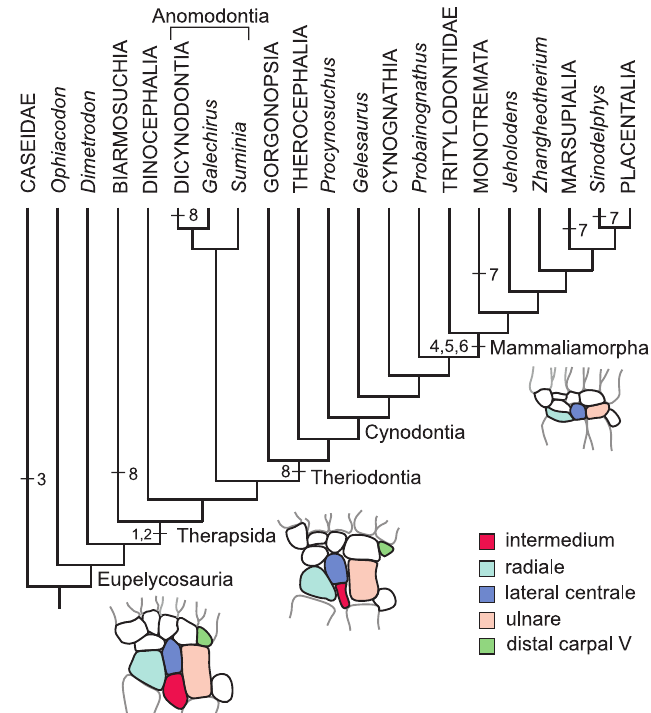
Fig. 17. Phylogenetic tree showing the major evolutionary changes in the carpus during synapsid evolution. For explanation, see text. The phylogeny is based on the same references as Fig. 2A and donts ( Exaeretodon and Procynosuchus RC92; SOM: fig. 2, table 7: b). In caseids, one synapomorphy seems to be a distal contact of the lateral centrale to the medial centrale (Fig. 17: character 3; SOM: table 5: c), whereas the placement of the lateral centrale lateral to the radiale is a synapomorphy of cynodonts (SOM: table 1: f). In mammaliamorphs, the in-